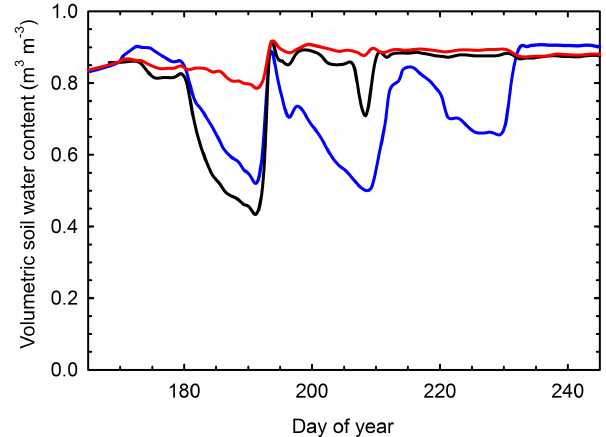
Figure 12. Volumetric soil water content measured in the centre of the ambient plot (blue), the control chamber (black) and the ZPW chamber